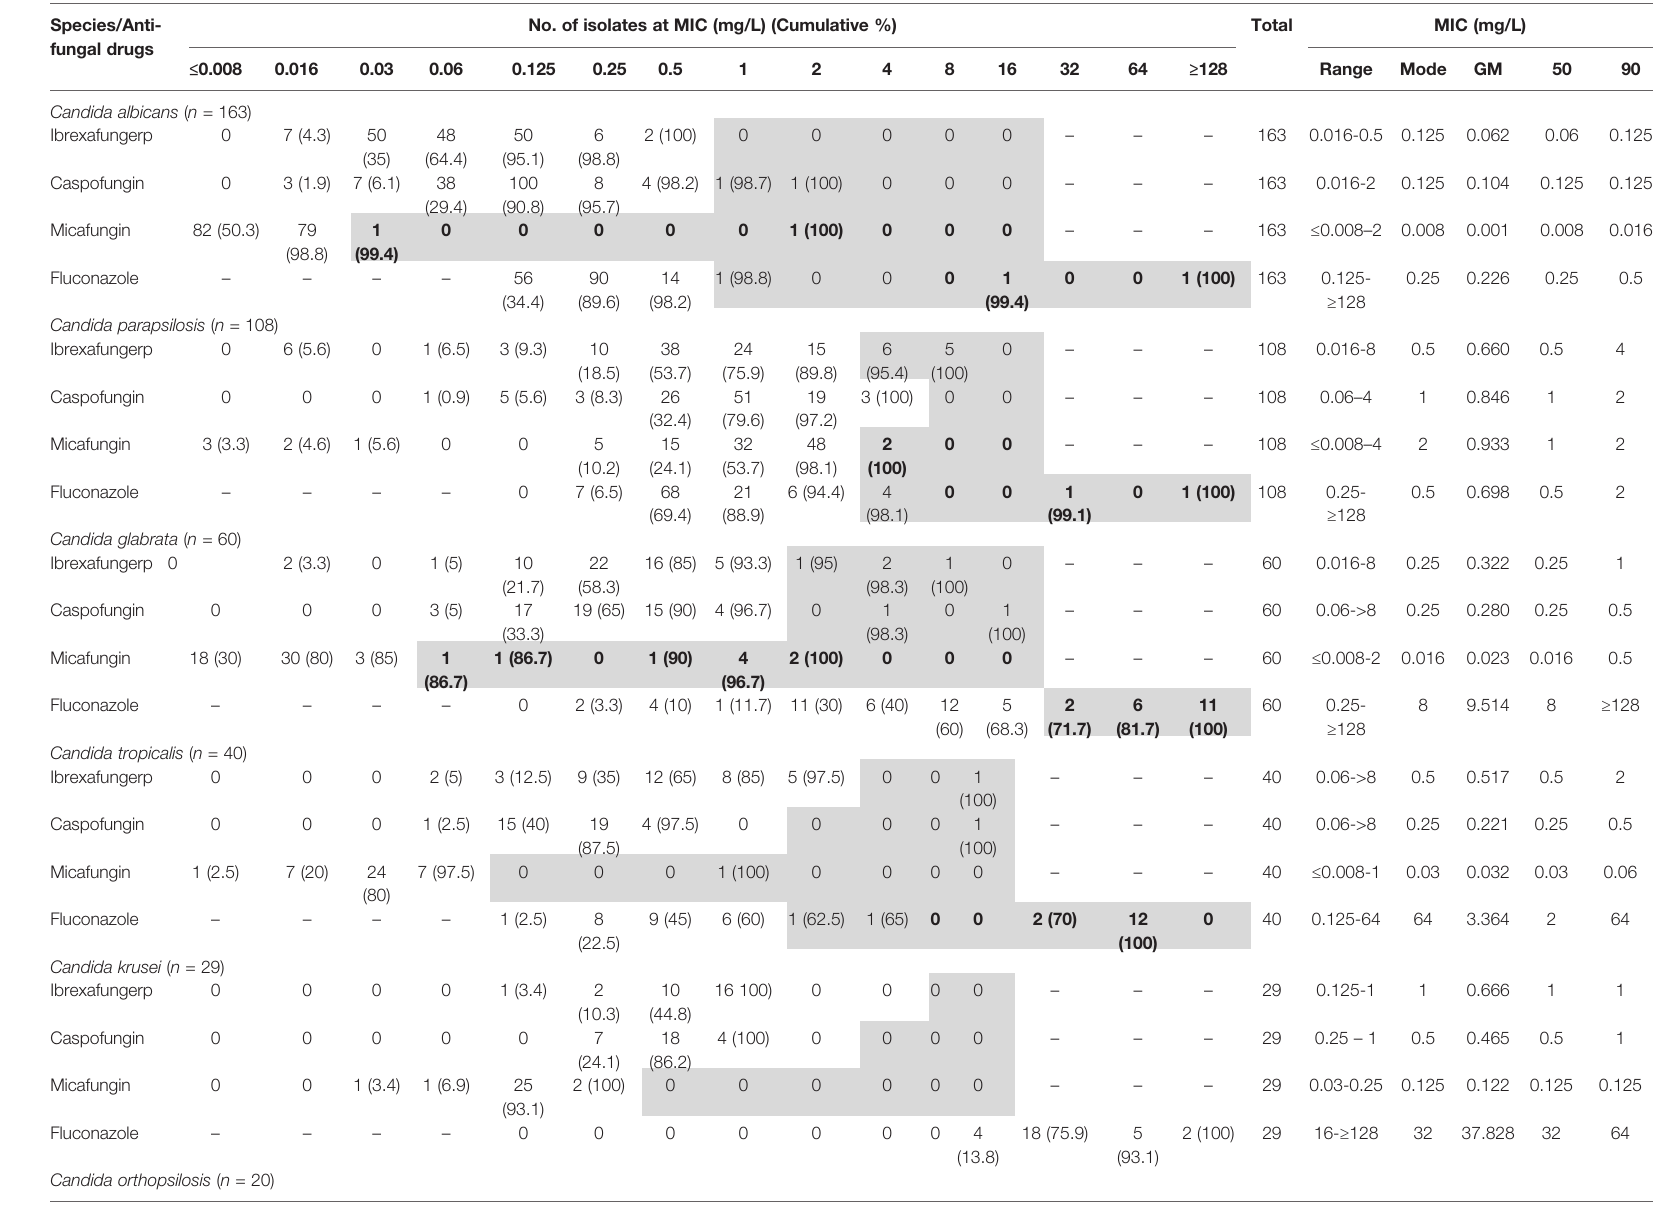
TABLE 2 | Summary of ibrexafungerp and comparators ’ in vitro antifungal activities against blood isolates from medically relevant species of Candida . Species/Anti- fungal drugs